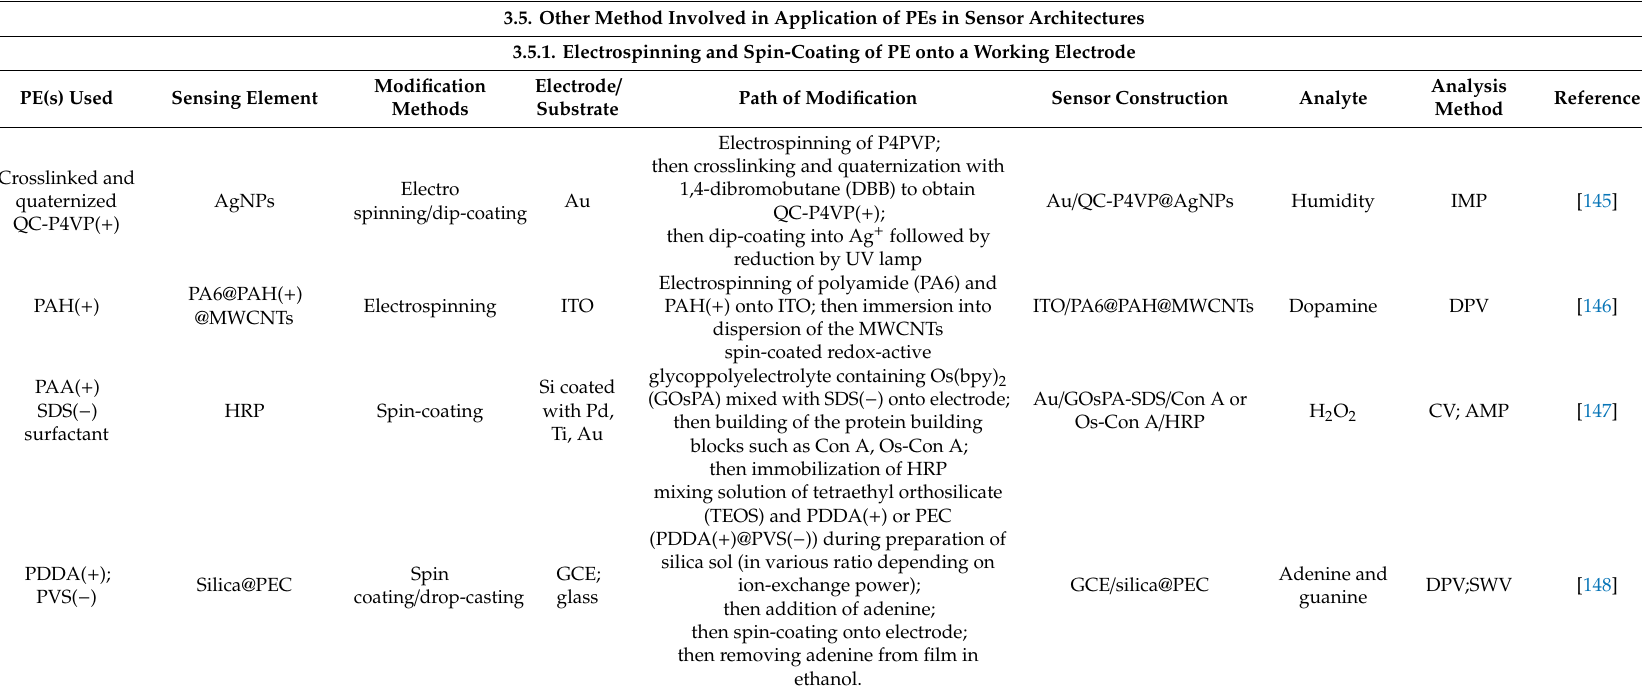
Table 9. Summary of electrochemical sensors based on other methods that involve polyelectrolytes in sensor